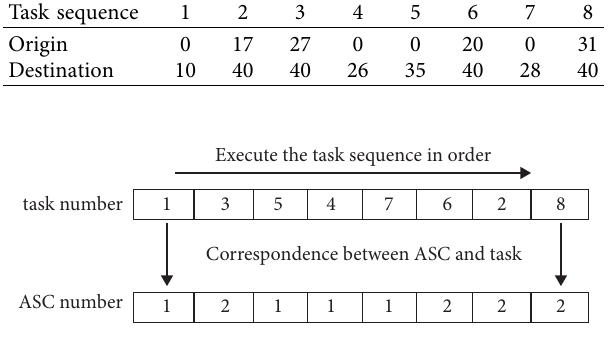
Figure 6: Chromosome encoding and decoding diagram.